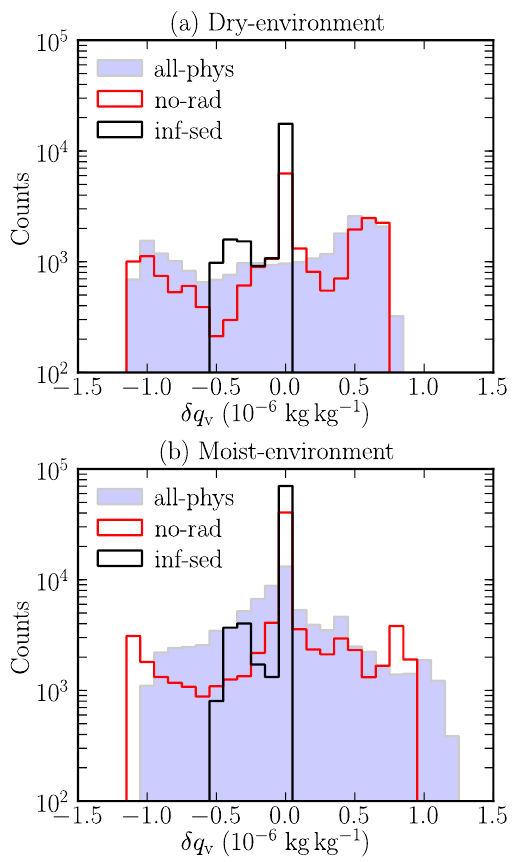
Figure 7. Histograms (in log scale) of changes in specific humidity over the integration (final minus initial) of all cloudy air parcels (for which q i > 5 × 10 − 8 kgkg − 1 in at least one of the all-phys or no-rad